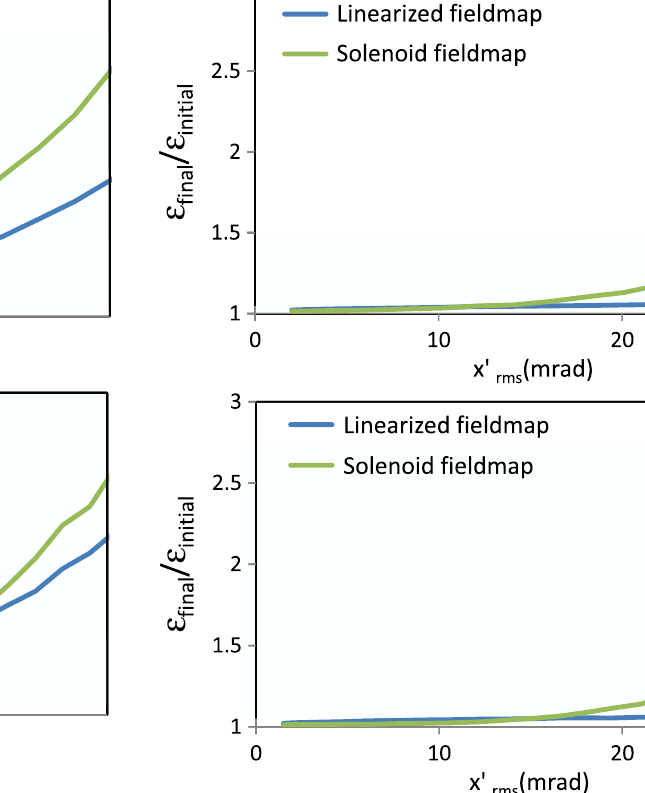
FIG. 8. (Color) Increase of emittance in solenoidal channels, B ¼ 0 : 6 T . Top: initial emittance 8 : 0 (cid:3) mm mrad . Bottom: initial emittance 4 : 5 (cid:3) mm mrad .